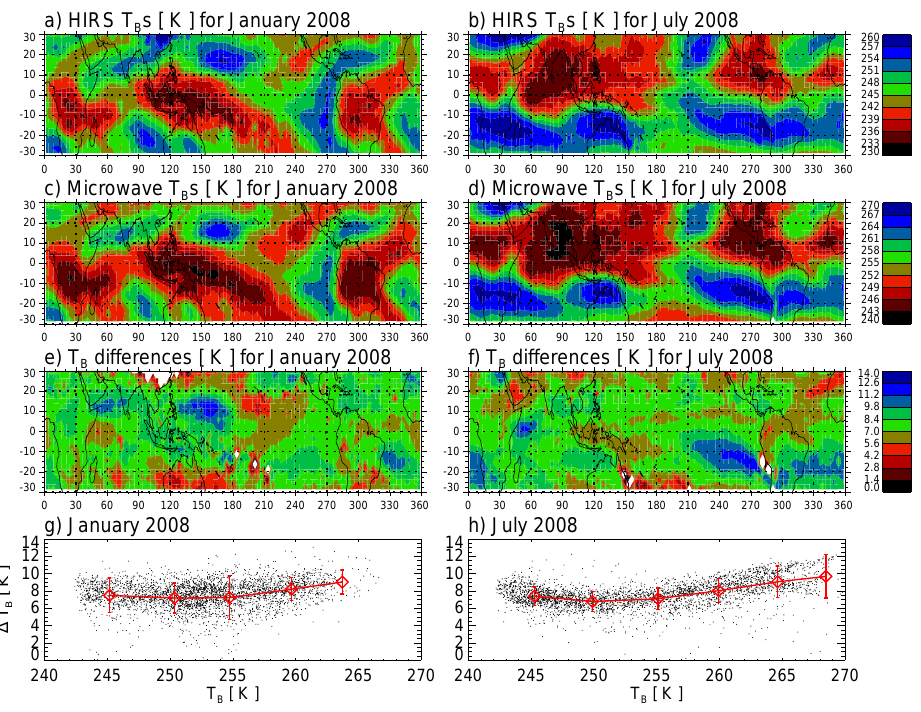
Fig. 5. HIRS and microwave channel T B s and their differences for (left) January and for (right) July 2008. Note that there is a 10K difference in the color scale between the HIRS plots (panels a–b) and the microwave plots (panels c–d). Bottom panels show the differences (microwave minus HIRS) as function of microwave T B s. Red symbols show mean differences and their standard deviations for 5K T B bins.